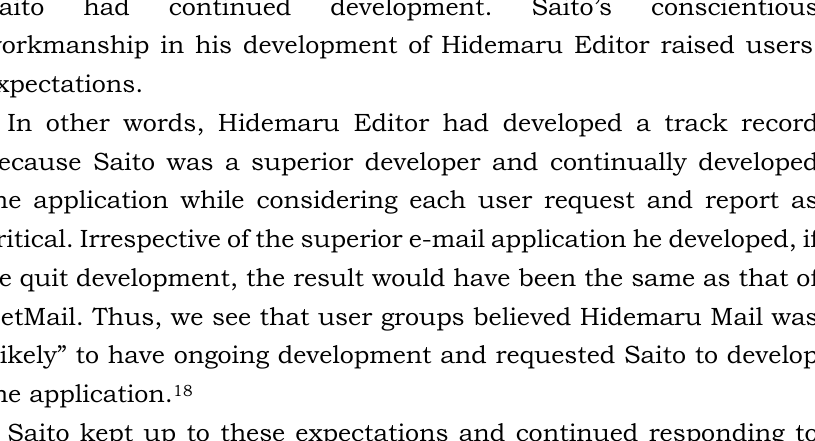
shows how Saito and users groups